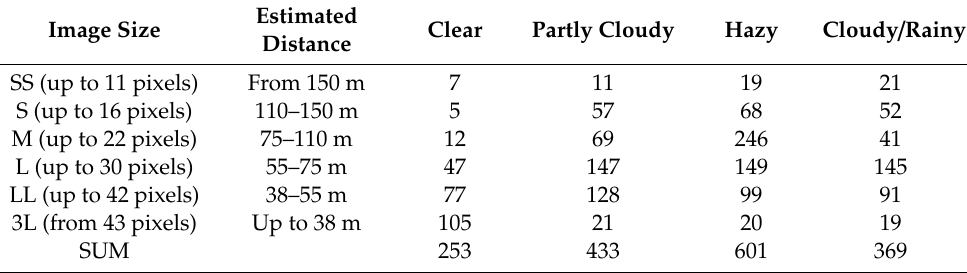
Table 1. Number of images by size and weather.